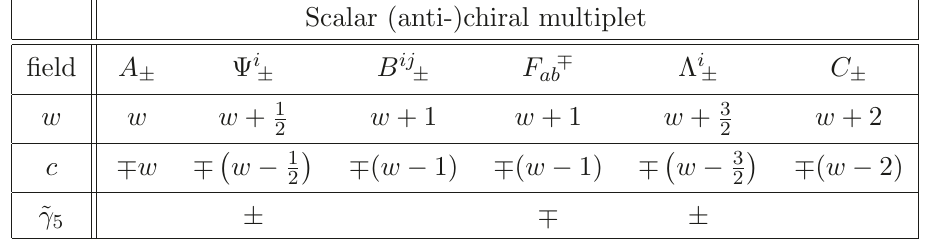
Table 3 . Weyl and chiral weights ( w and c ) and fermion chirality/two-form duality (˜ γ 5 ) of scalar (anti-)chiral multiplet component fields. Note that the chiral (anti-chiral) multiplet contains fermion components of positive (negative) chirality and Lorentz two-forms that are anti-self-dual (self-dual). All bosonic fields are